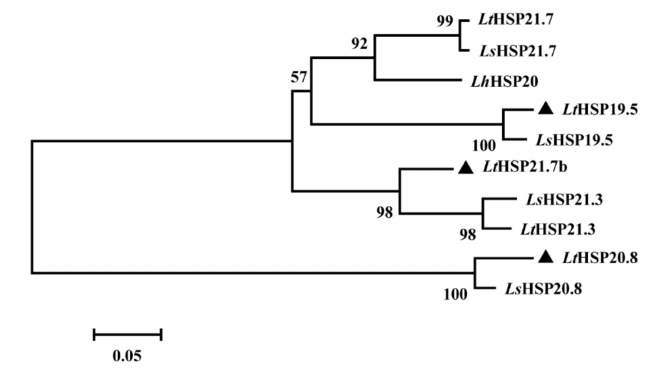
Figure 3. Neighbor-joining phylogenetic tree of Liriomyza sHSPs. Those three new L. trifolii sHSPs of this study are labeled with triangles. Numbers on the branches are the bootstrap values obtained from 1000 replicates (only bootstrap values > 50 are shown). Abbreviations, species, and accession numbers include LtHSP21.7 ( L. trifolii , KY558641); LsHSP21.7 ( L. sativae , DQ452372); LhHSP20 ( L. huidobrensis , DQ452370); LtHSP19.5 ( L. trifolii , MG195951); LsHSP19.5 ( L. sativae , DQ452373); LtHSP21.7b ( L. trifolii , MG195953); LsHSP21.3 ( L. sativae , DQ452371); LtHSP21.3 ( L. trifolii , KY231145); LtHSP20.8 ( L. trifolii